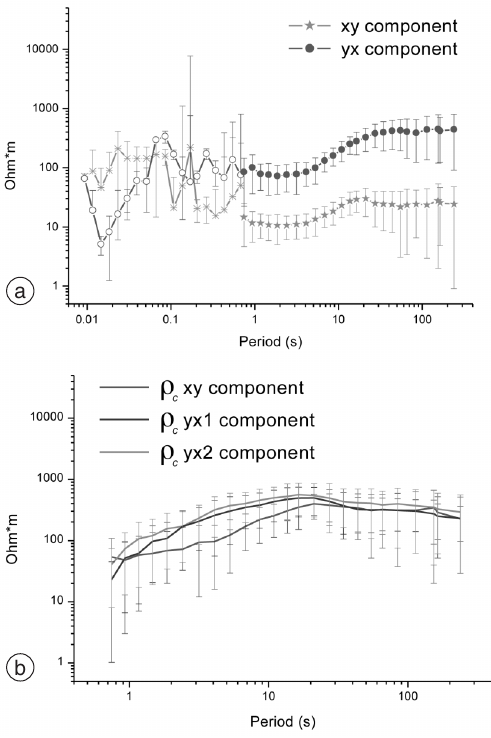
a) Characteristic apparent resistivity curve and error bars in high and low frequency band relative to MN site; b) characteristic apparent resis- tivity curve and error bars low frequency band rela- tive to TR